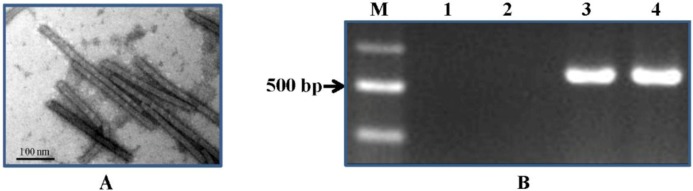
Confirmation of CGMMV-infection in cucumber samples (cv. Zhongnong 16).A, CGMMV particles in infected cucumber leaves observed by SEM. B. Gel electrophoresis of RT-PCR using CGMMV specific primers. M, DNA ladder; 1, Sample from uninfected plants; 2, Blank control; 3, Sample from infected plant; 4, Infected leaves obtained from CAIQ used as a positive control.